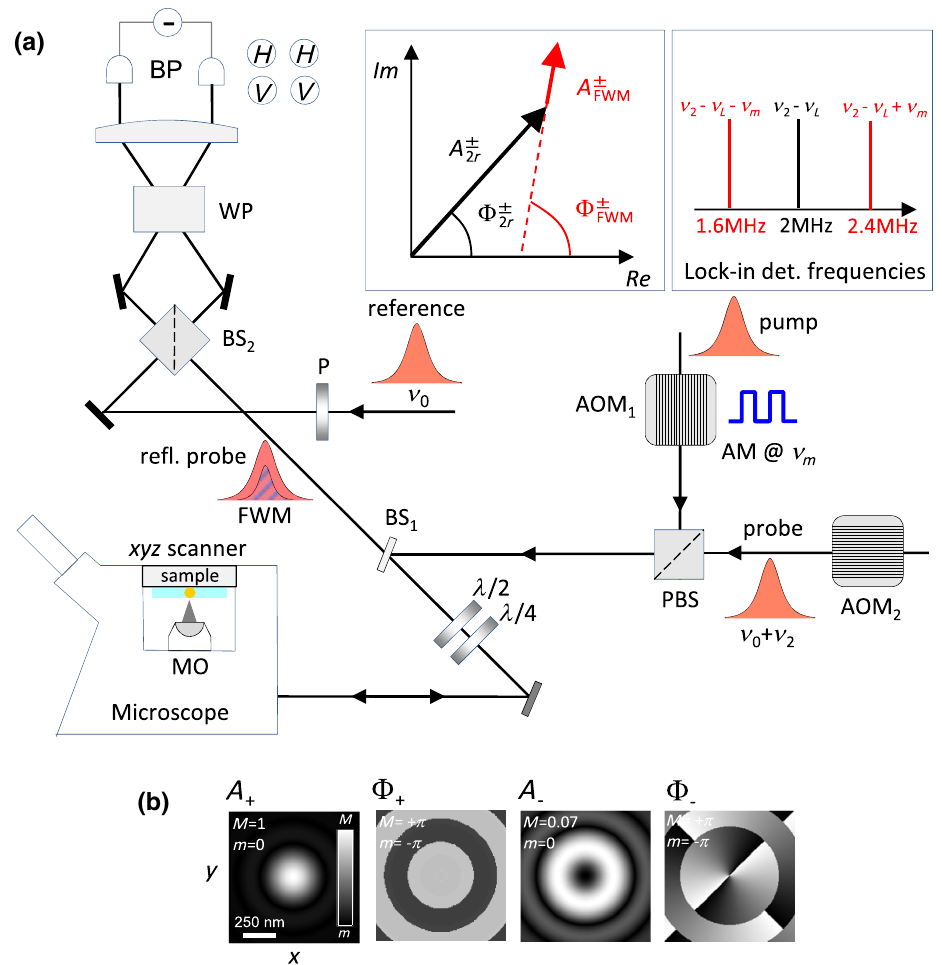
FIG. 1. Four-wave-mixing interferometry epidetected dual-polarization resolved. (a) Sketch of pump pulses that are amplitude modulated (AM) at ν m and probe pulses that are frequency shifted by ν 2 , using acousto-optical modulators (AOMs). Pulses are coupled into an inverted microscope equipped with a high NA microscope objective (MO). Pump and probe beams are adjusted to be circularly polarized at the sample by λ = 4 and λ = 2 wave plates. Circular polarizations are transformed into horizontal ( H ) and vertical ( V ) linear polarization by the same wave plates, and both components are simultaneously detected through their interference with a frequency- unshifted reference linearly polarized at 45°. BP: Balanced photodiodes. WP: Wollaston prism deflecting beam out of drawing plane. ( P ) BS: (Polarizing) Beam splitter. P : Polarizer. Inset: Amplitude ( A ) and phase ( Φ ) of the reflected probe and FWM field, measured by a multichannel lock-in, where þ ( − ) refers to the co-(cross-)polarized component relative to the incident circularly polarized probe. (b) Calculated field distribution in the focal plane of a 1.45 NA objective for an incident field left circularly polarized. Here, A þ ð A − Þ is the co-(cross-)polarized amplitude, and Φ þ ( Φ − ) is the corresponding